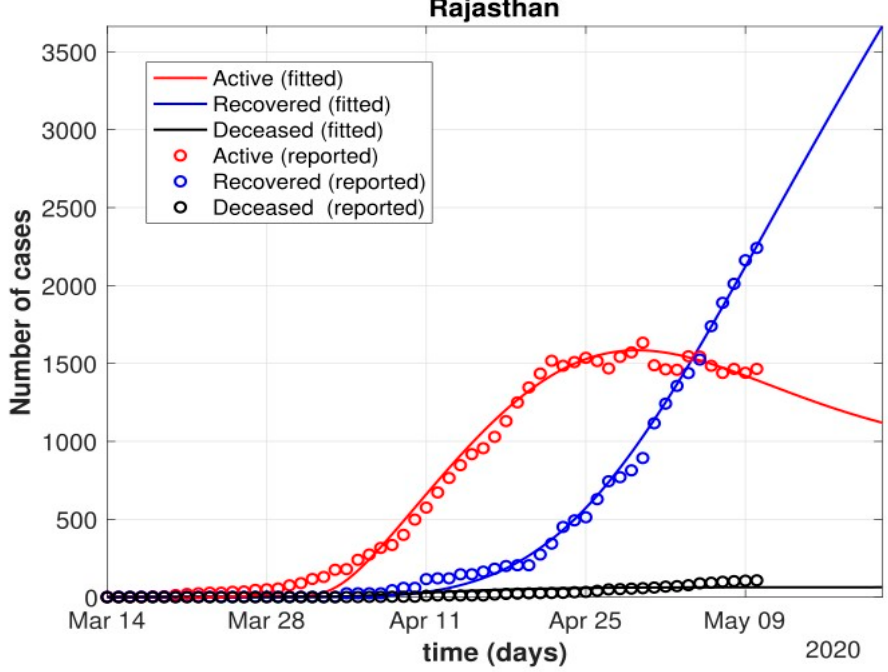
Figure 14. Fit of the proposed model (1) for the number of COVID-19 cases in Rajasthan.